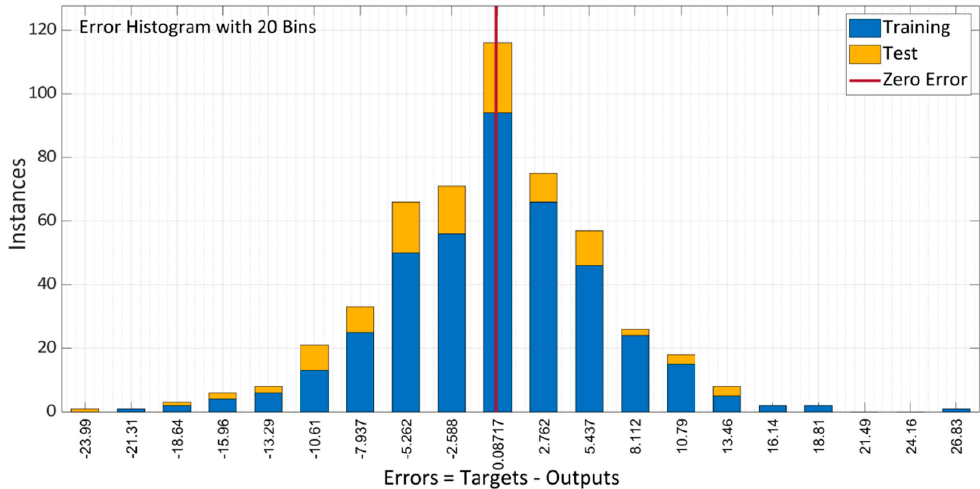
Table 5. Summary of BR algorithm model assessment parameters. Phase